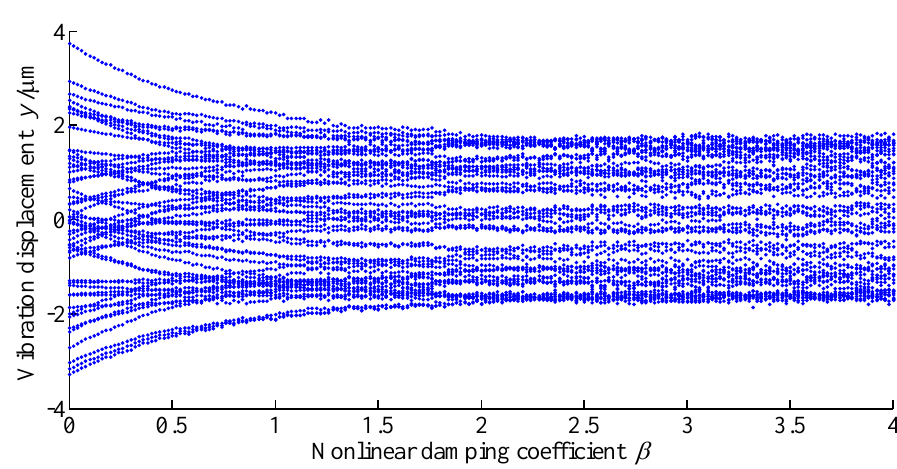
Figure 8. Bifurcation diagram with the variation of β .